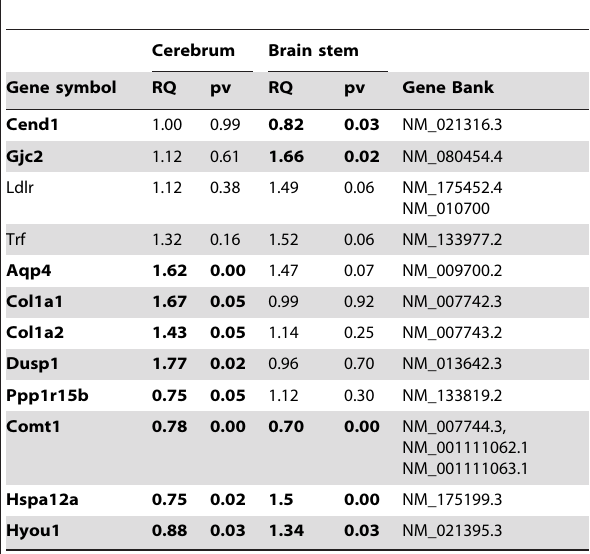
Table 3. Spatial dynamics of differential gene expression at